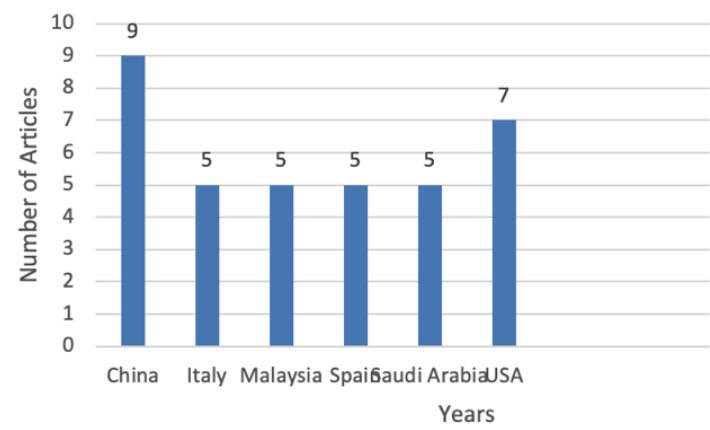
Figure 1: Time distribution of corporate governance and ownership